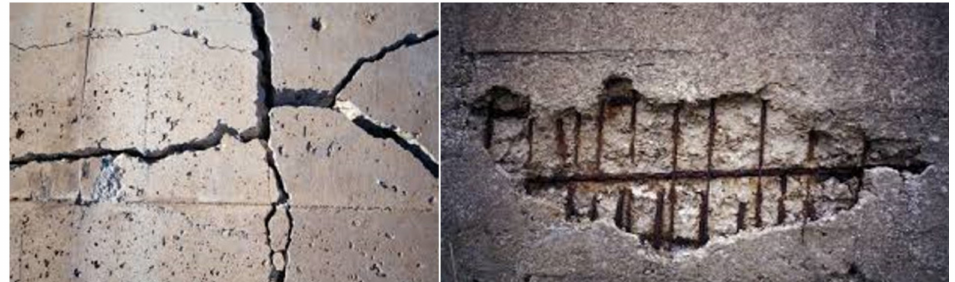
Figure 5. Fissuring and chipping due to element breakage in a marine environment structure (source: own collection).